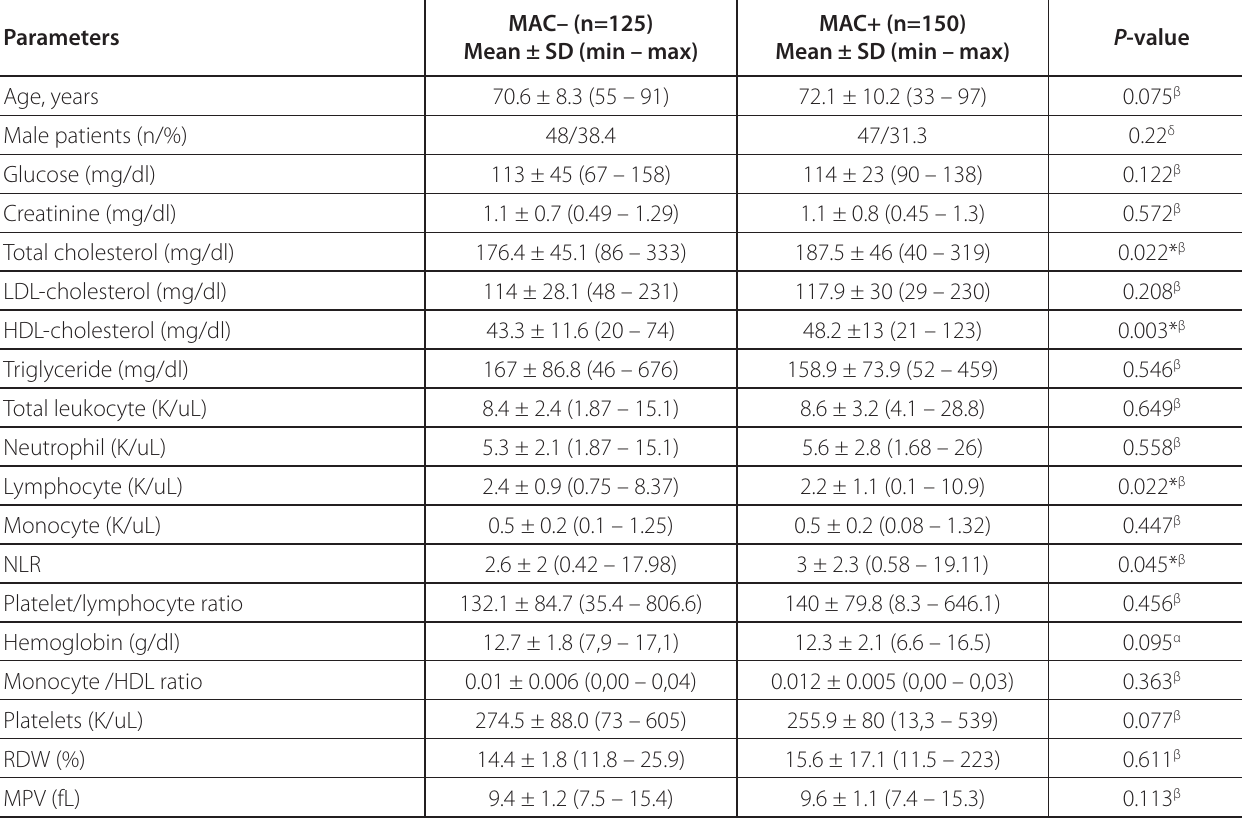
Table 1 . Demographic characteristics, biochemical parameters, and whole blood parameters of the